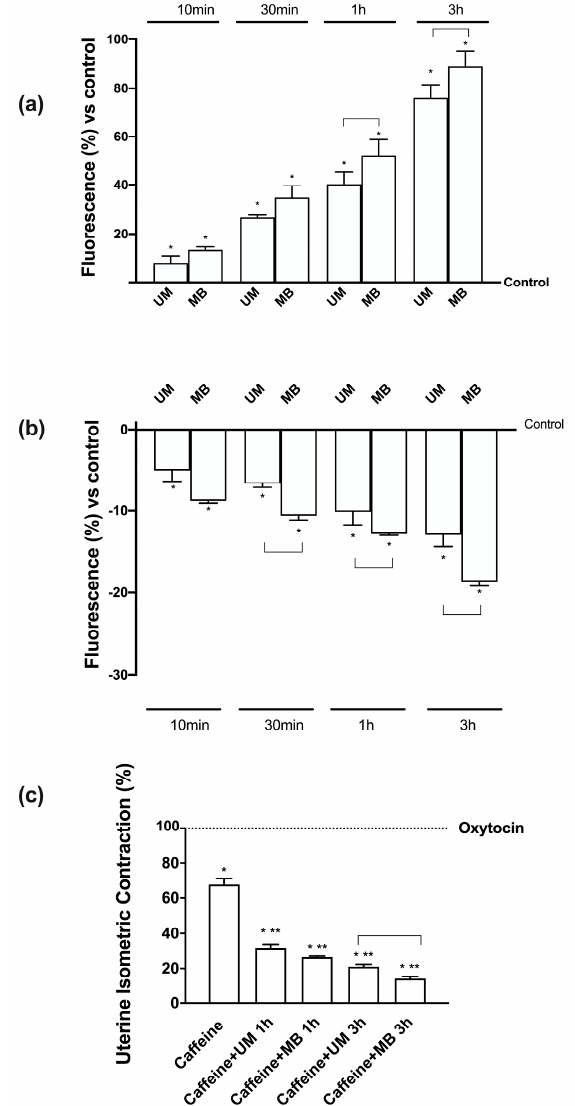
Figure 6. Measurements of Mg 2 + and Ca 2 + flux on PHN1-41 cells and mouse contractility assay. ( a ) Free intracellular magnesium concentration ([Mg2 + ]i) as measured before (basal [Mg 2 + ]i) and after Mg-loading by UM and MB. After measurement of the basal [Mg 2 + ]i in Na- and Mg-free medium, Caco-2 cells were Mg-loaded by Furaptra, and post-loading [Mg 2 + ]i was calculated from the values measured over time. ( b ) Free calcium concentration ([Ca 2 + ]) as measured before (basal) and after Mg-loading by UM and MB. After measurement of the basal [Ca 2 + ] in Na-, Ca-, and Mg-free medium, Caco-2 cells were loaded with Fura2, and post-loading [Ca 2 + ] was calculated from the values measured over time. Values are means ± SD (%) of six single experiments. * p < 0.05 vs. control; the bars indicate p < 0.05 between UM and MB at the same time point. ( c ) Analysis of contractility assay on mouse strips is reported. Data are expressed as means ± SD of four experiments normalized to the maximal contraction obtained using 10 − 6 M oxytocin. * p < 0.05 vs. oxytocin; ** p < 0.05 vs. caffeine; the bars indicate p < 0.05 between UM and MB at the same time point. The abbreviations are the same as reported in Figure 1.